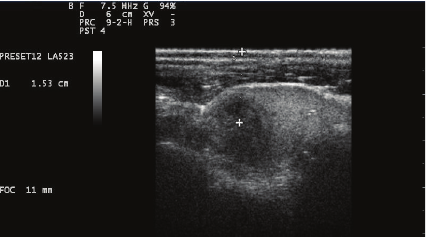
Figure 1: Transverse ultrasonographic image of the right lobe of the thyroid gland showing a 1.7cm diameter, hypoechoic, circular masswithinthethyroidgland.Imageobtainedwitha7.5 MHz,linear